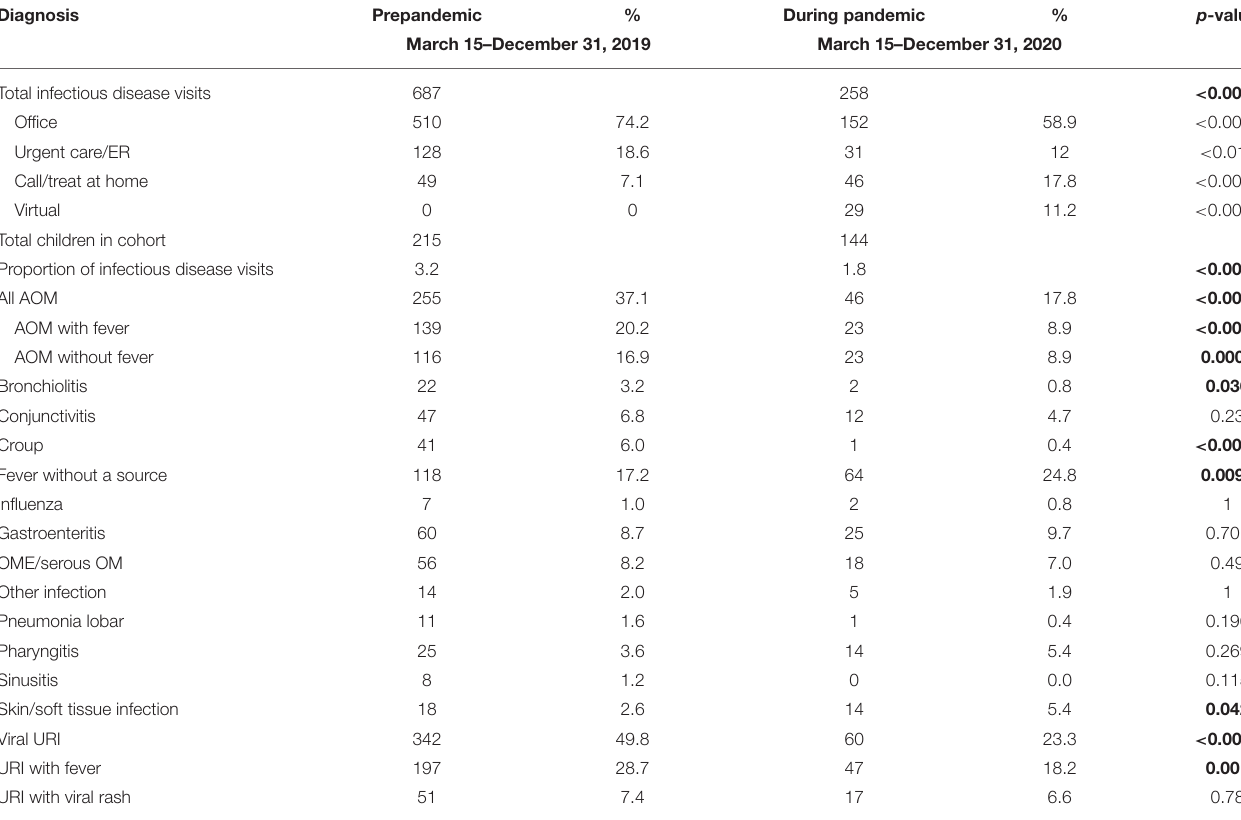
TABLE 1 | Comparison of children with all physician-diagnosed, medically attended infectious disease visits in children before and during the COVID-19 pandemic. Diagnosis Prepandemic % During pandemic % p